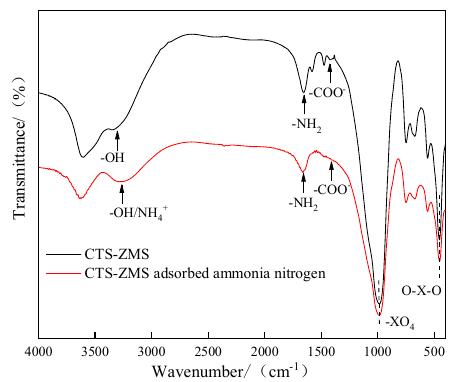
Figure 6. FTIR spectra of the CTS-ZMS samples before and after ammonium nitrogen adsorption.